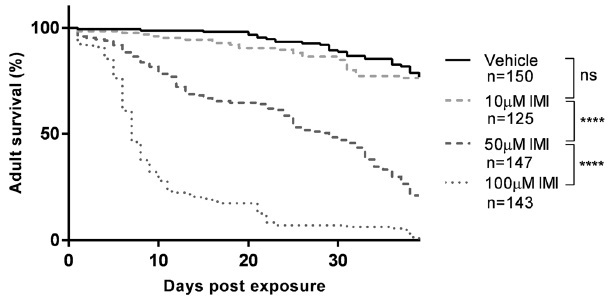
Figure 1. IMI exposure in D . melanogaster results in dose dependent toxicity. Survival curves for newly eclosed wildtype Canton-S flies fed food containing vehicle or food containing varying concentrations of IMI. Data are displayed from at least 5 independent experiments (20–25 flies each group per experiment). All statistical symbols are representative of comparison made using the log-rank (Mantel-Cox) test. **** p < 0.0001. ns = not